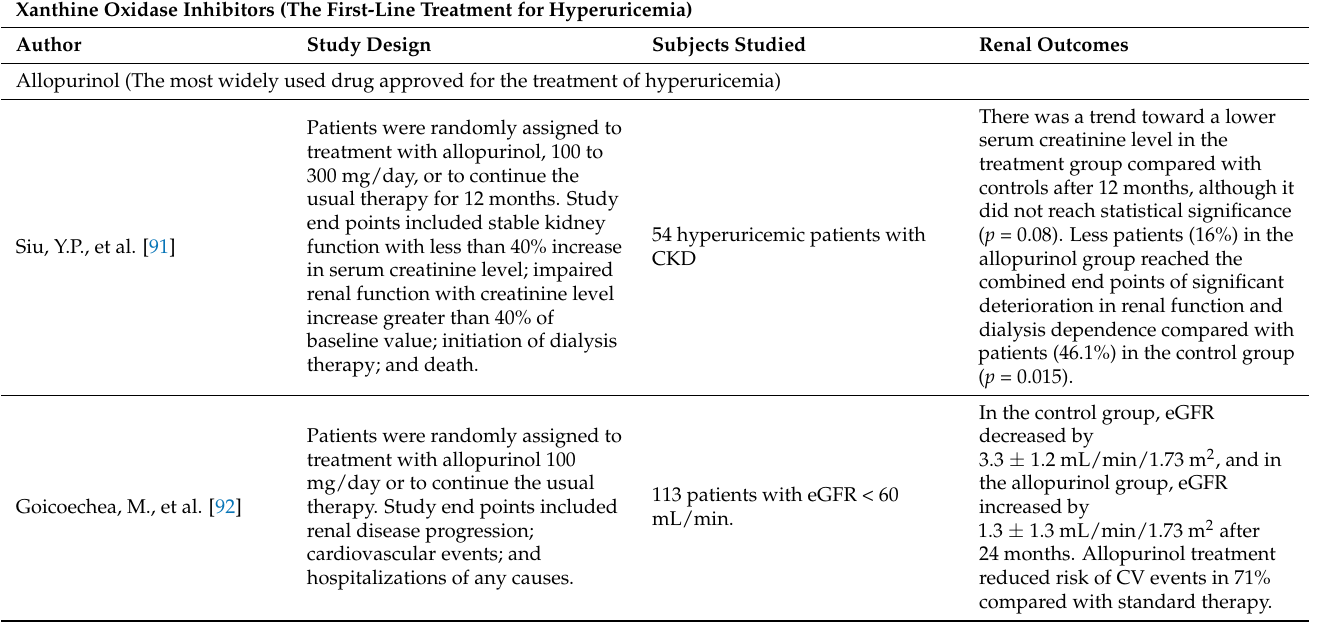
Table 1. Renal Outcomes by UA Lowering